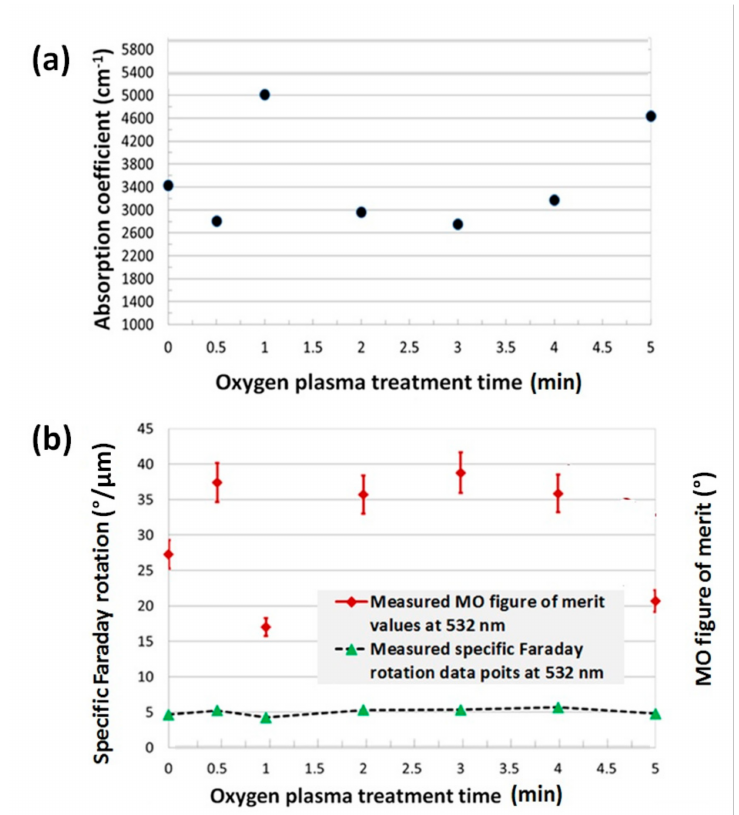
Figure 5. Measured optical absorption coe ffi cients ( a ), specific Faraday rotation and MO figure of merit data points ( b ) at 532 nm in optimally annealed O 2 plasma treated and non-treated Bi 1.8 Lu 1.2 Fe 3.6 Al 1.4 O 12 garnet